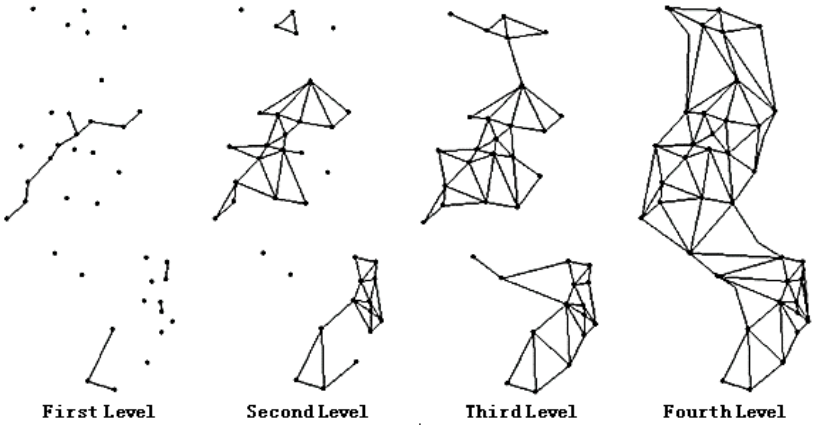
Figure 5. Representation of four-level linear ecological